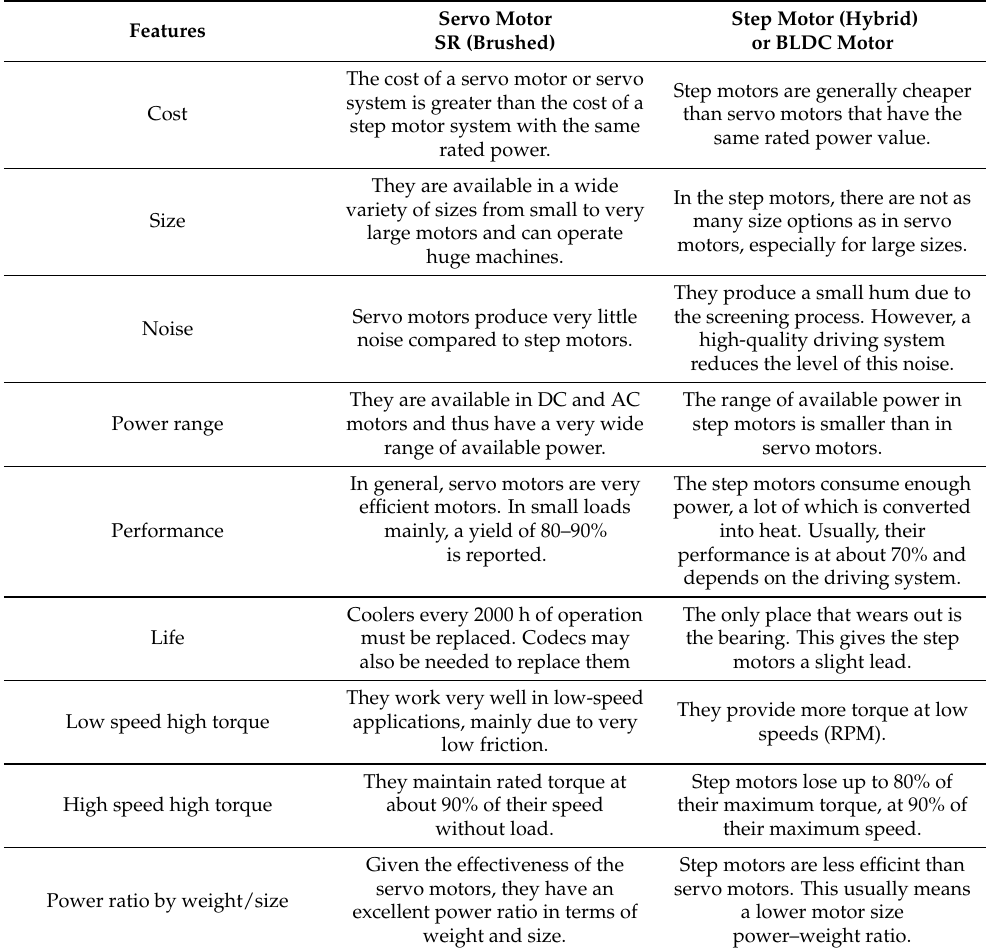
Table 1. Comparison of SR servo motor with brushes and hybrid stepper motor or BLDC